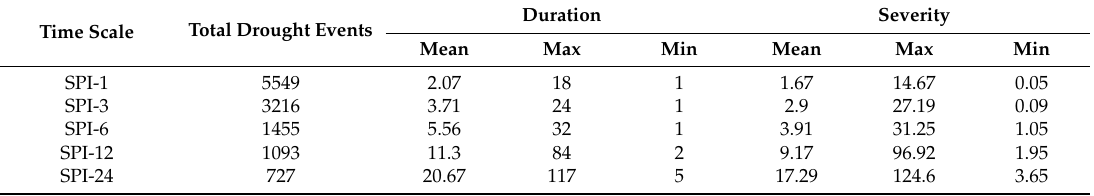
Table 2. Characteristics of drought with changes in SPI-time scale for 55 stations across South Korea. Time Scale Total Drought Events